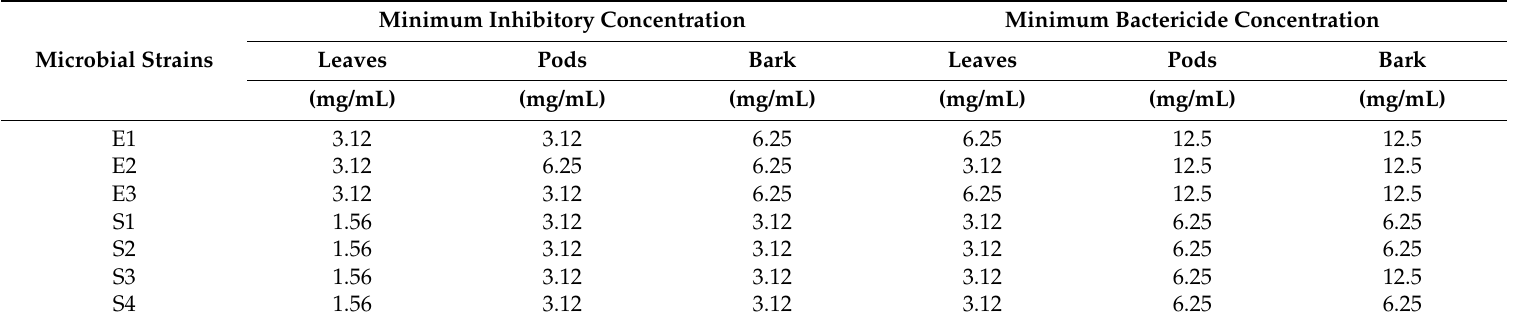
Table 3. Minimum inhibitory concentration (MIC) and minimum bactericidal concentration (MBC) of A. nilotica extracts. Minimum Inhibitory Concentration Minimum Bactericide Concentration Leaves Pods Bark Leaves Pods Microbial Strains